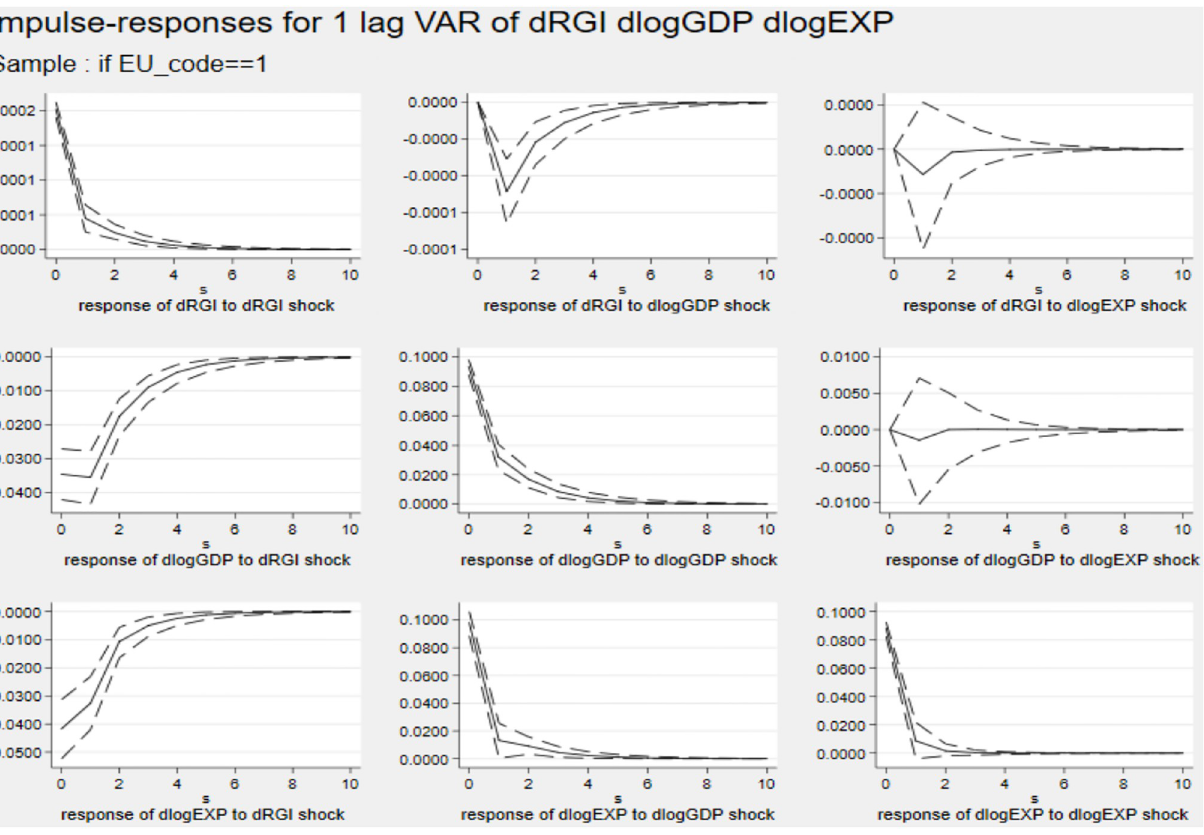
Fig 5. Impulse response diagram in Cluster 4. Notes : Errors are 5% on each side generated by Monte-Carlo with 2000 reps.